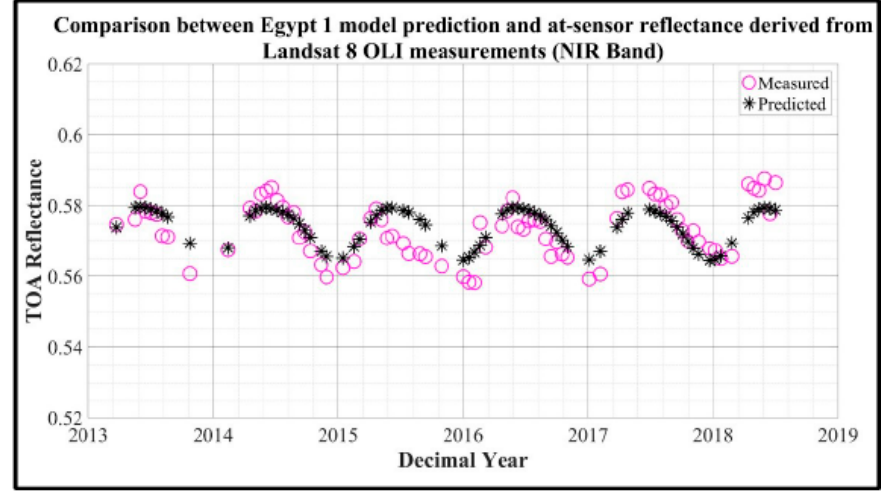
Figure 2. Egypt 1 model predicted (black asterisk) and Landsat 8 OLI observation (magenta circle) [49].